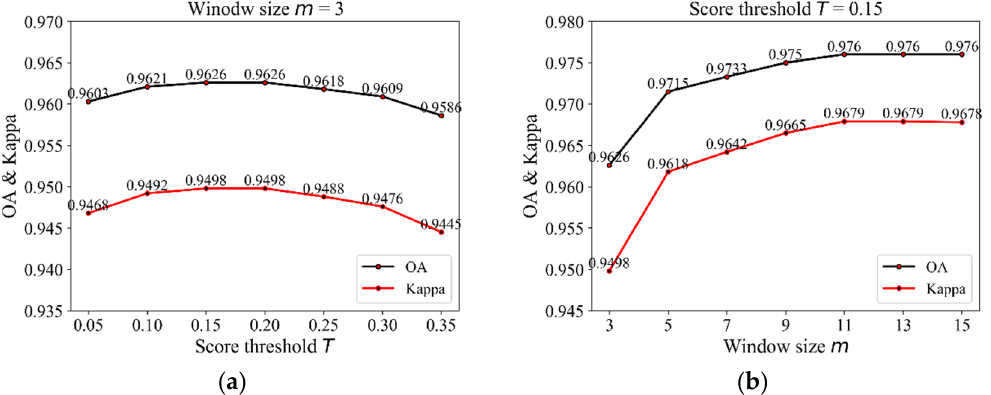
Figure 11. Impact analysis of the critical parameters on the classification accuracy. ( a ) Relationship between OA and kappa and the category score thresholds when the window size m = 3. ( b ) Relationship between OA and kappa and the neighborhood window sizes when the score threshold T = 0.15.